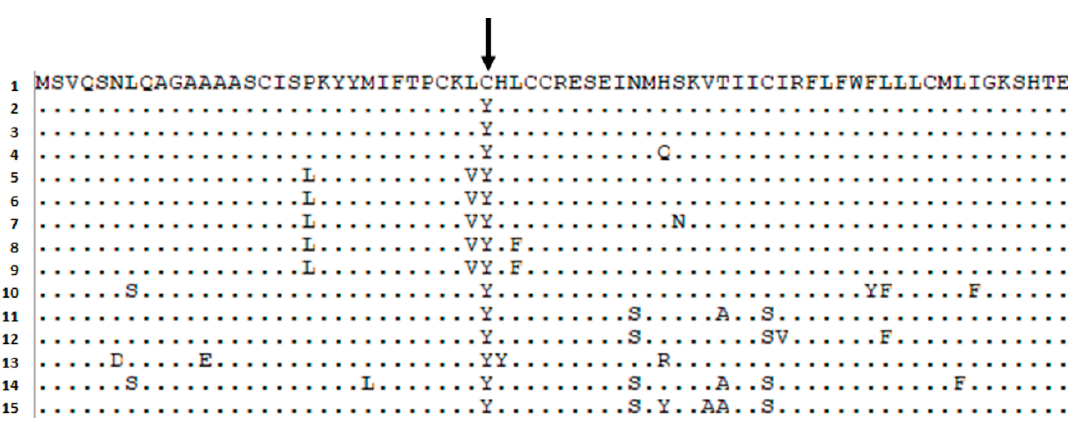
Figure 1. Evolutionary conservation of the N-terminal extended 70 aa. BChE fragment. Position of p.C-11Y (rs1126680) (or p.C31Y counted from the start of the protein) is marked by a black arrow. BLASTP search of BChE proteins of the 14 closest living relatives: 1—( Homo sapiens ) EAW78592.1; 2—